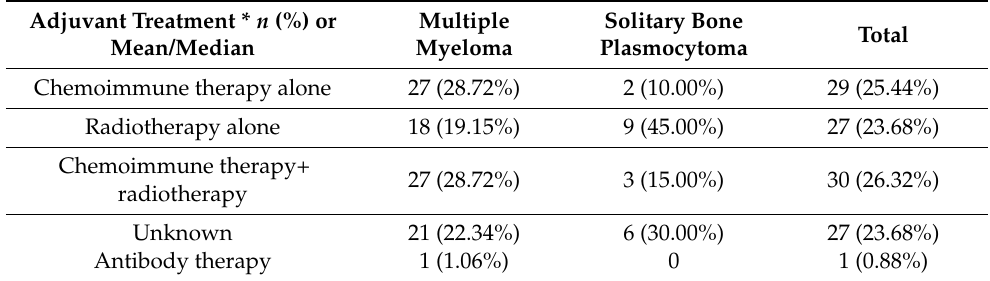
Table 3. Adjuvant therapy divided according to multiple myeloma and solitary bone plasmacytoma.